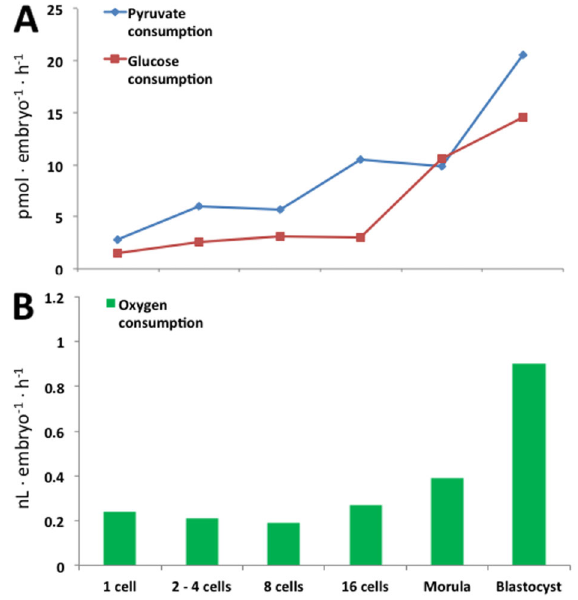
Figure 2. Glucose, pyruvate and oxygen consumption during embryo preimplantation stages. Measurements were performed in isolated in vitro embryos (adapted from Refs. 13 and 14, with permission).